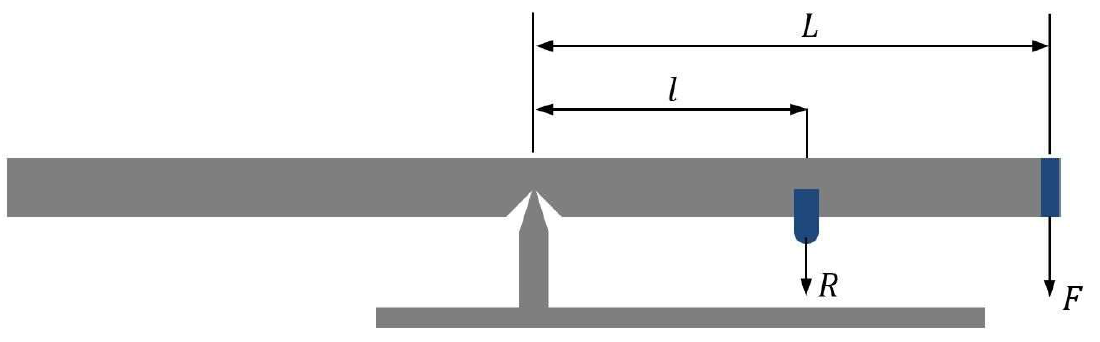
Figure 2. The indentation test rig.